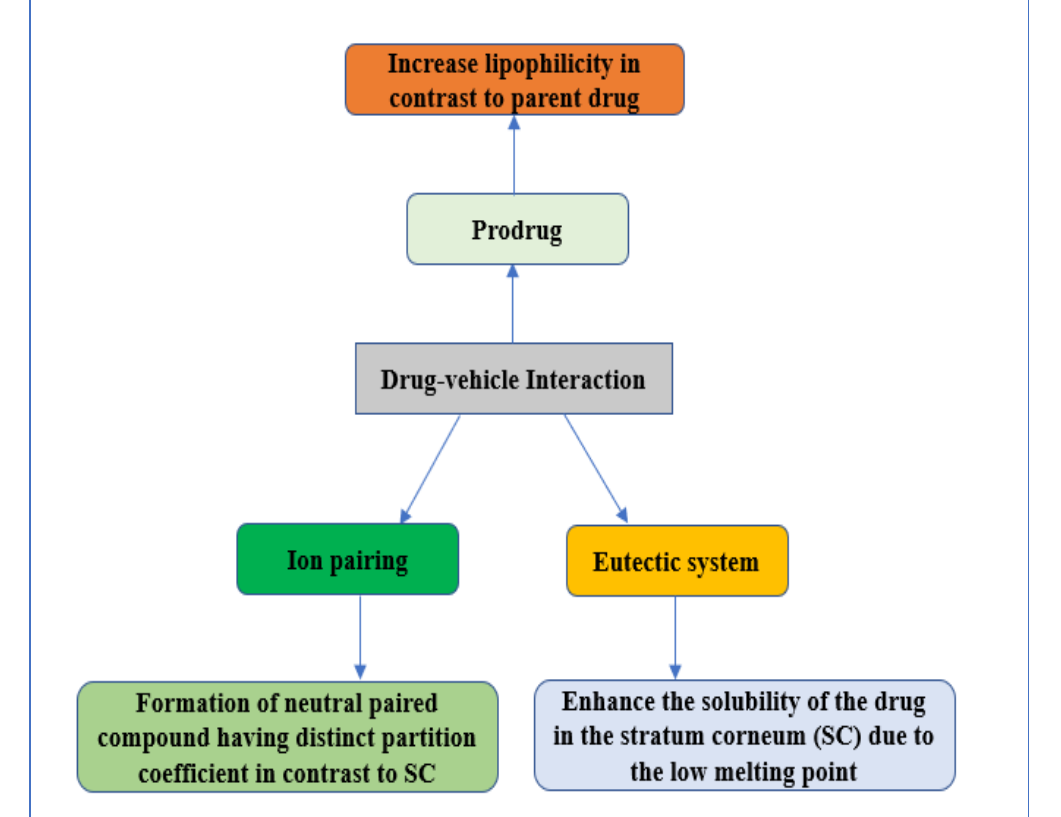
Figure 4. Permeation process through the skin via drug – vehicle interaction.